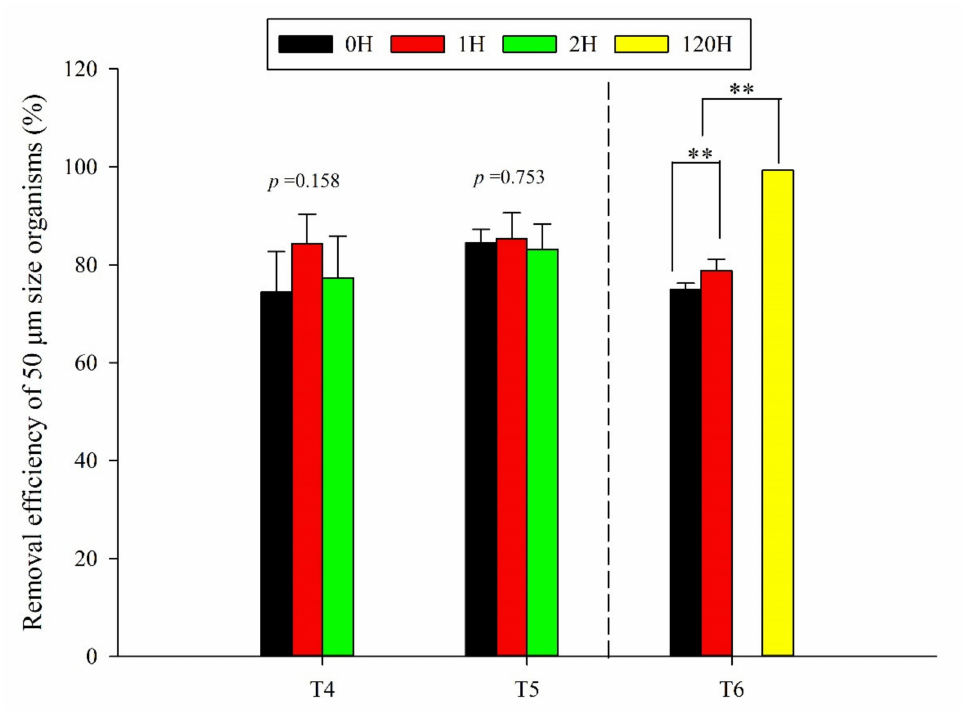
Figure 6. Statistical analysis by removal efficiency over time of zooplankton species (statistical significance levels lower than p < 0.05 ‘*’ or p < 0.01 is referred as